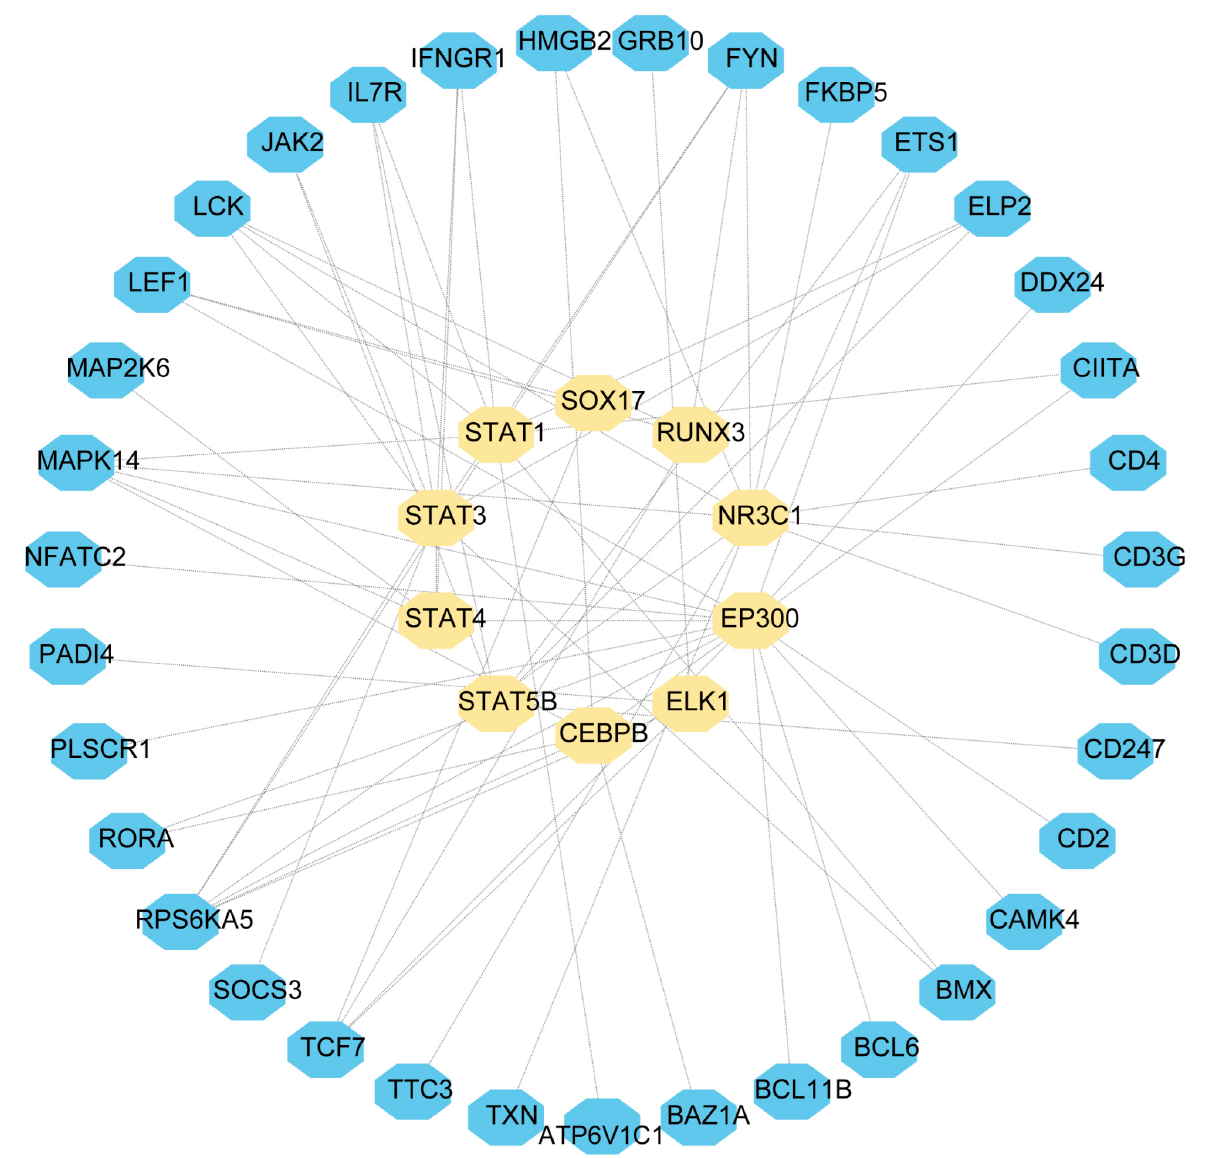
Figure 6. DEGs-TF were used as nodes in an interconnected regulatory network. Light yellow hexagon nodes represent TFs, and genes interact with TFs as blue hexagon nodes.